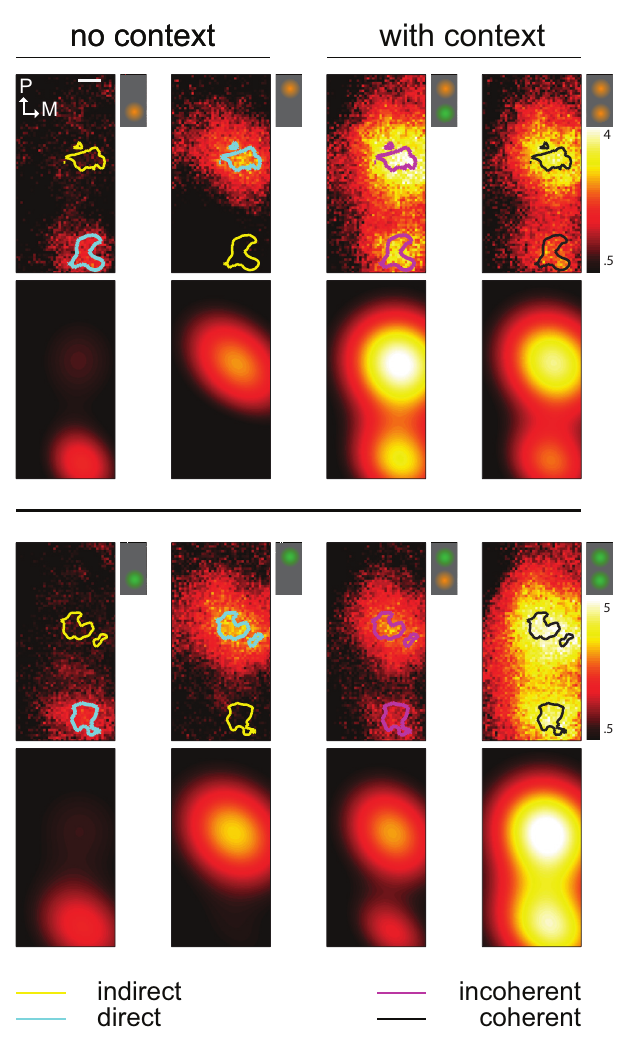
Figure 3. Observed and modeled spatial profiles of activity patterns. Spatial activity profiles ( first and third rows) in response to two different natural movies ( upper and lower panels) presented at various stimulation conditions with ( third and fourth columns) or without ( first and second columns) contextual information. Icons schematically represent the stimulation conditions. These are computed by time-averaging the data presented in Figure 2. Activity during no- context conditions was used to define a pair of interest regions per movie. This was done by selecting the pixels with highest activity located within the top 5 th percentile (see contour lines). Within these regions of interest we derived direct ( cyan ), indirect ( yellow ) and coherent ( black ) and incoherent ( magenta ) activity levels. The observed activity profiles were parametrically fitted using a composite function involving two 2-D Gaussians ( second and fourth rows). The goodness of fit values characterized by the correlation coefficient is shown for the whole data set in Figure 4D. Color scale represents Δ F/F (x10 -4